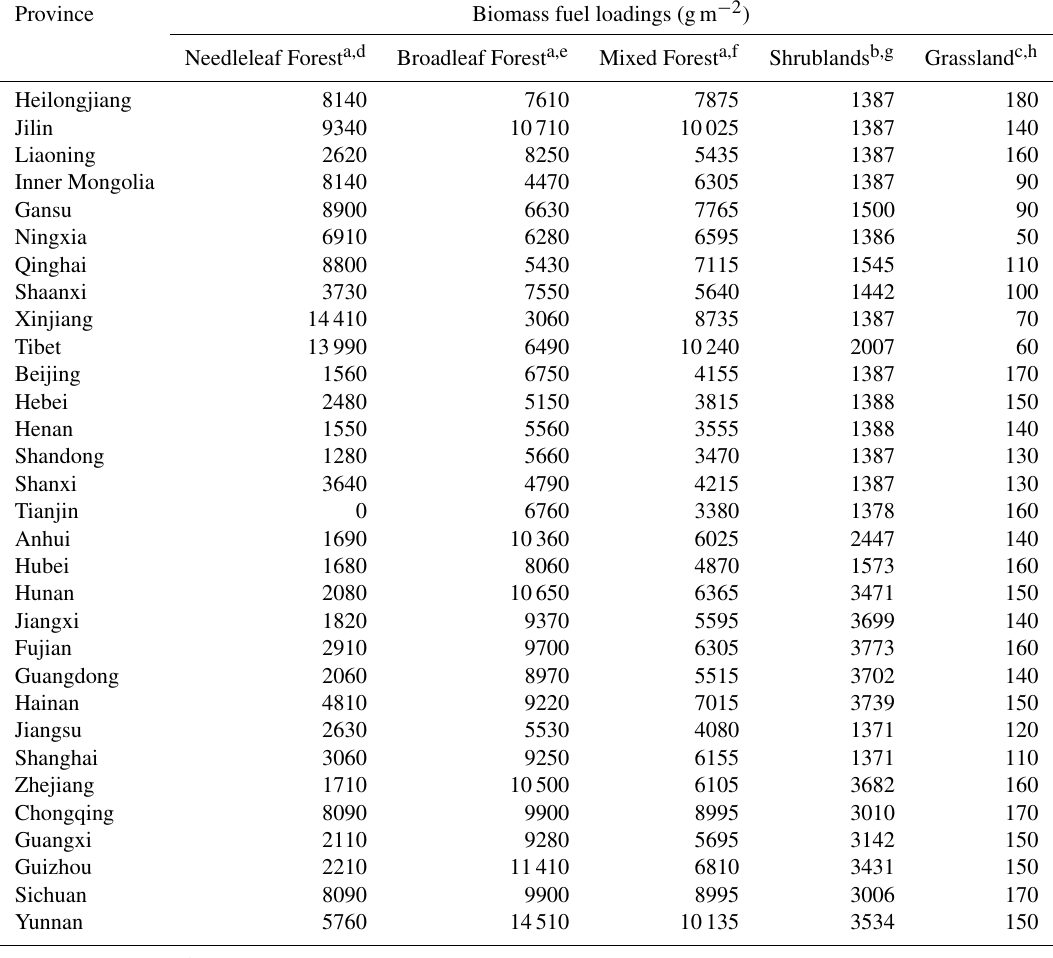
Table 4. Forest and grassland biomass fuel loadings in each province.